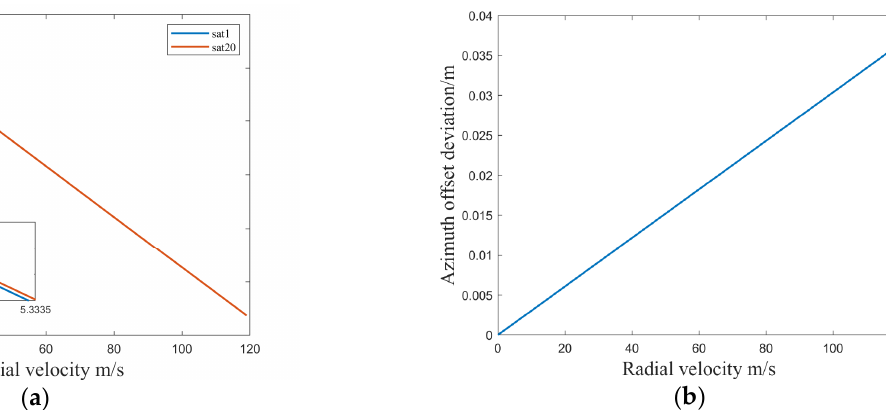
Figure 9. ( a ) Azimuth offset with the radial velocity between the 1st and 20th images; ( b ) azimuth offset deviation with the radial velocity between the 1st and 20th images.